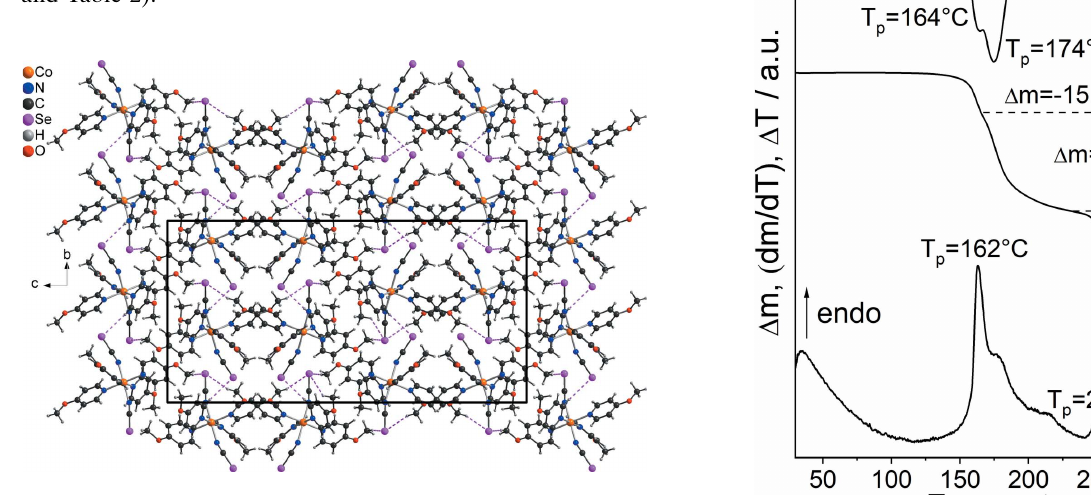
Figure 2 Crystal structure of the title compound viewed along the crystallographic a- axis direction. C—H (cid:2)(cid:2)(cid:2) Se interactions are shown as pink dashed lines.